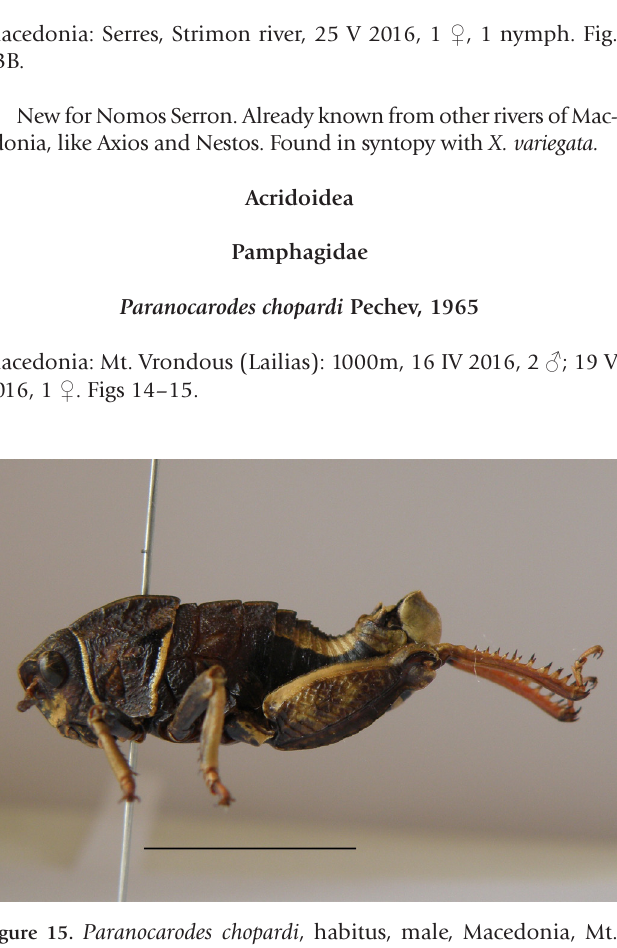
Figure 15. Paranocarodes chopardi , habitus, male, Macedonia, Mt. Vrondous, 16 IV 2016, lateral view (scale bar, 10 mm).